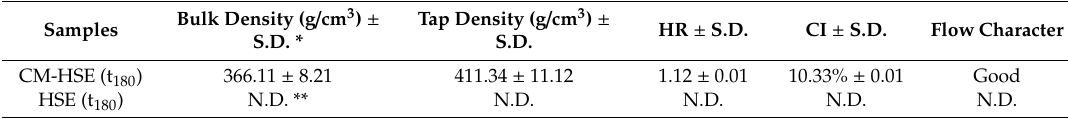
Table 5. Flow properties of CM-HSE powder after storage (t 180